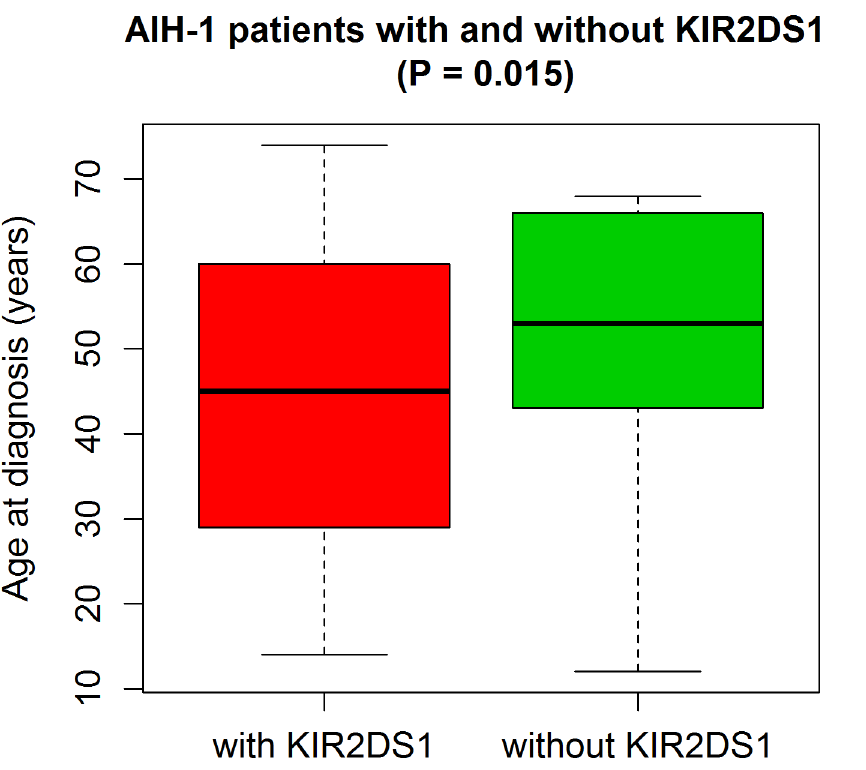
Fig 1. Predictive potential of the KIR2DS1 activating KIR gene for early onset of AIH-1.